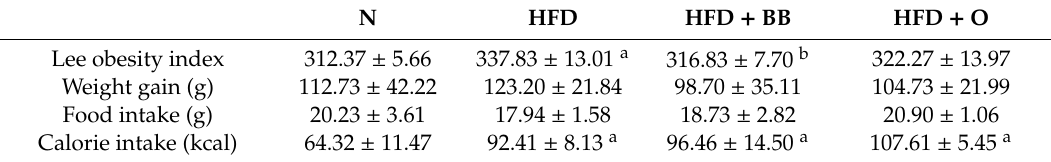
Table 3. The e ff ects of bee bread on Lee’s obesity index, weight gain, food, and calorie intake.